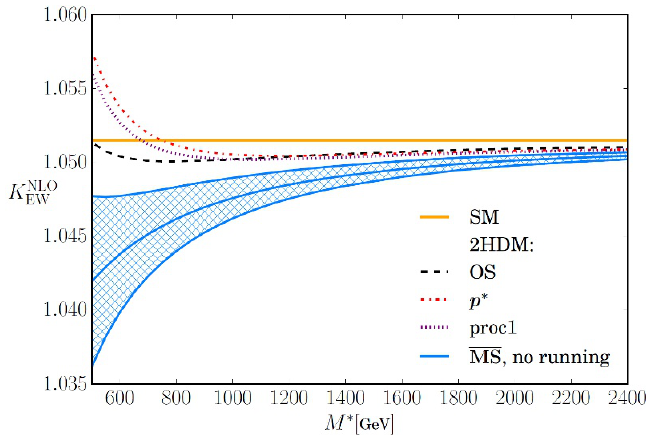
Figure 4 . Decoupling scenario for the process g + g